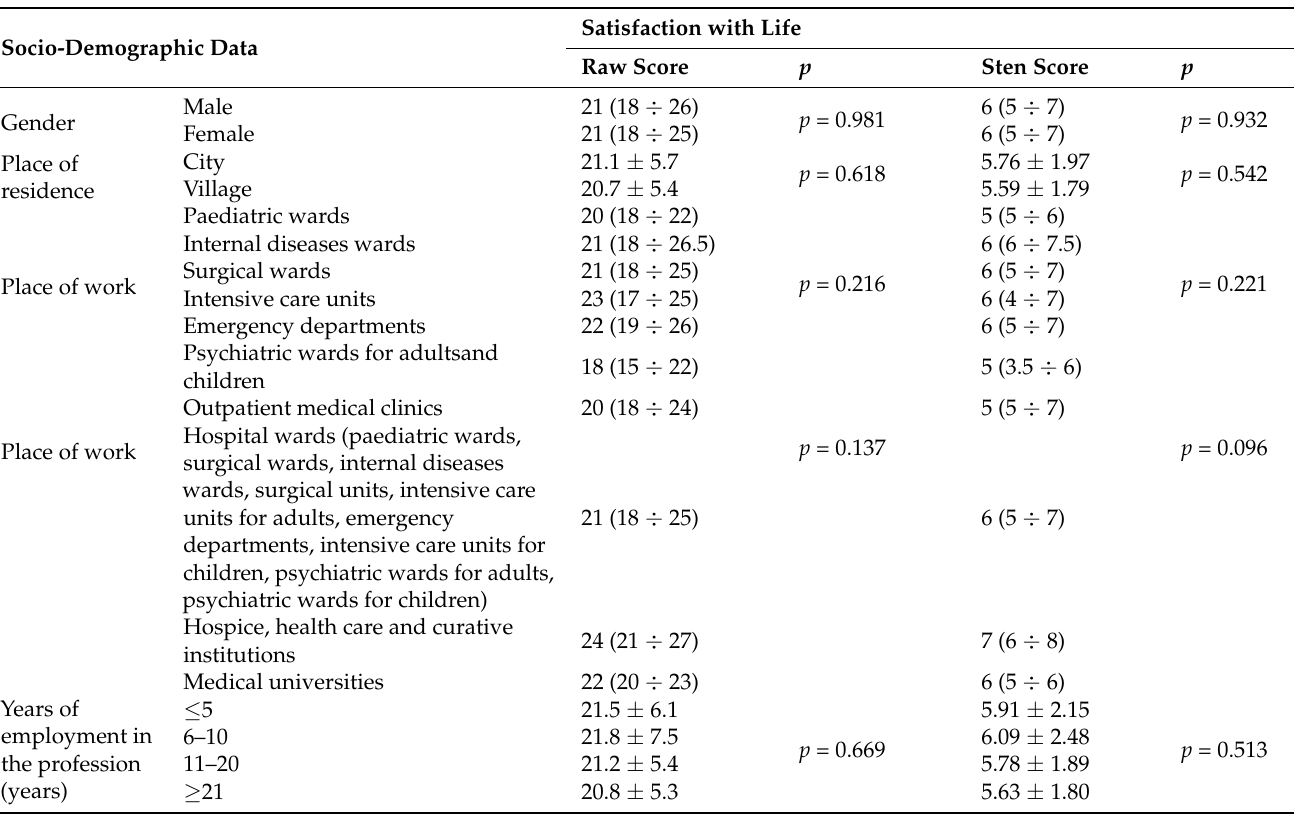
Table 4. Influence of various factors on satisfaction with